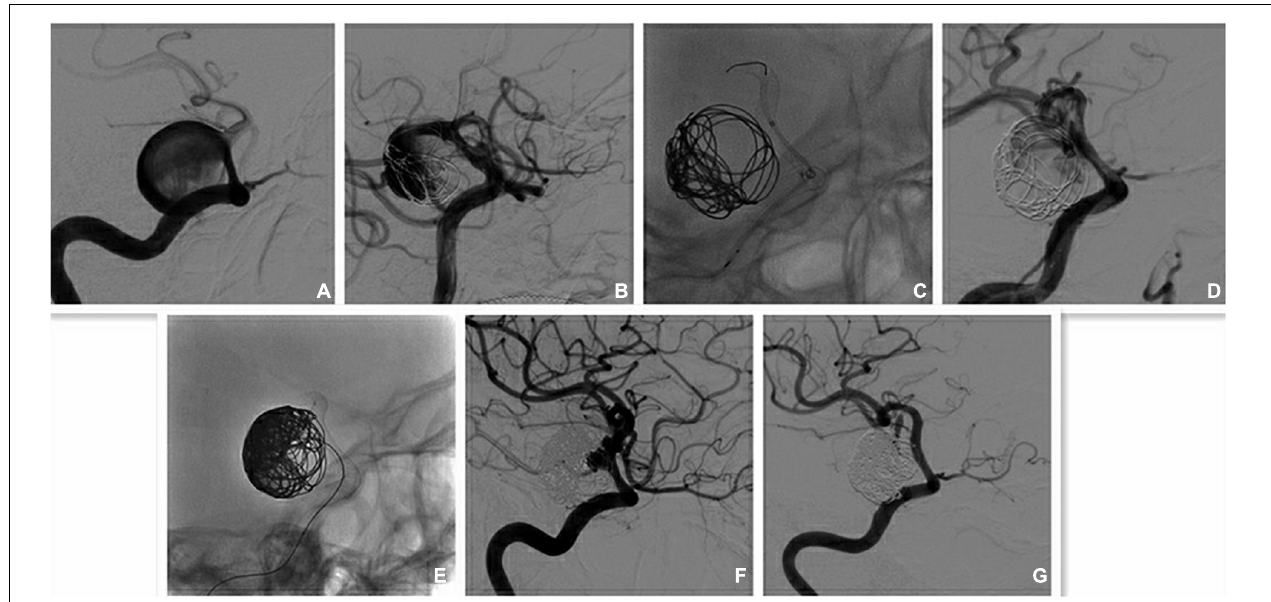
FIGURE 2 | Multi-PEDs for the treatment of a giant aneurysm (overlap technique). (A) Digital subtraction angiography (DSA) identified a large aneurysm with jet-sign at the narrow neck in the internal carotid artery (ICA) before operation. The proximal diameter and distal diameter were 4.55 and 3.77 mm, respectively. (B) The jet-sign is decreased slightly after the implantation of a pipeline embolization device (PED; 4.25 mm × 35 mm) and coil embolization. (C) The second PED (4.5 mm × 18 mm) was overlapped within the first one to cover the neck. (D) The ejection (jet-sign) is decreased largely after the implantation of two PEDs and coil embolization. (E) More coil was used to fill the entrance area of the sac. (F) DSA shows that the aneurysm was nearly occluded a week after operation. (G) The aneurysm is completely occluded, and the patency of the parent arteries is satisfactory at the 3-month DSA follow-up